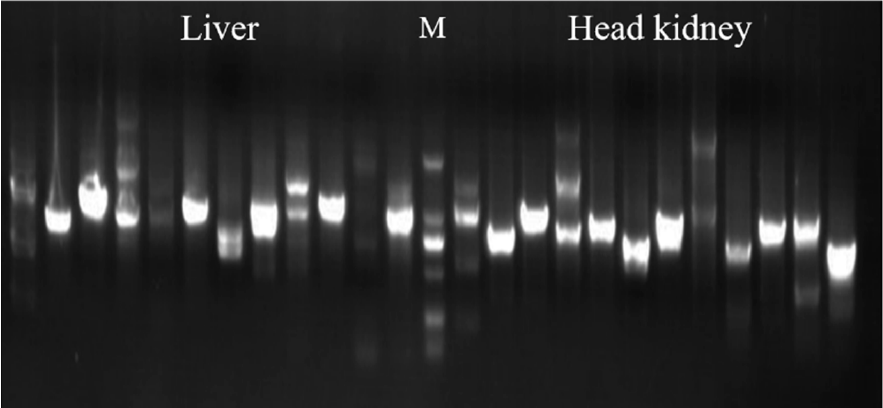
Figure 1. Detection of the size of the liver and head kidney libraries of Y2H. Note: M (marker): 2000, 1000, 750, 500, 250, and 100 bp.